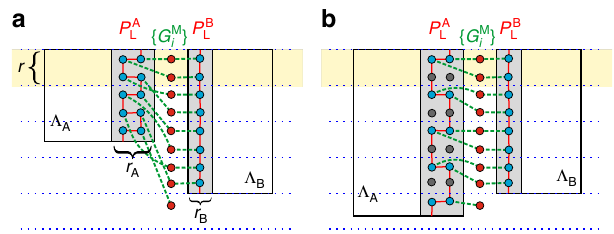
Fig. 1 Subsystem lattice surgery between two topological codes. a Depiction of two topological codes de fi ned on lattices Λ A and Λ B (grid not shown), respectively. Logical Pauli operators P I of the respective codes I = L A, B are represented by solid red lines connecting qubits (blue dots) within Λ Λ A and B , respectively. These operators have support on a vertical strip (gray areas) of width r I for I = A,B. Qubits in the support of P I are L associated with a set Q I . Ancillas added in step (i) of the merging protocol are depicted as red dots and are associated with a set Q C . Merging operations G M i , which are de fi ned in Eq. (2), are indicated (in part) by dashed green lines (with only the i th component being covered). The product of all merging operations acts as P A such that a collective (cid:2) P B L L measurement projects onto a joint eigenstate of the two logical operators. Here, the diameter of an operator G M i can grow with the lattice sizes since r > r A B . b Adding redundant vertices (gray dots) to the lattices increases the interaction range of the codes such that Q A , Q B , and Q C contain the same number of qubits within each horizontal strip of thickness r between adjacent blue, dashed lines (e.g., the yellow area). Then, the diameter of merging operators can be kept constant, i.e., independent of the system